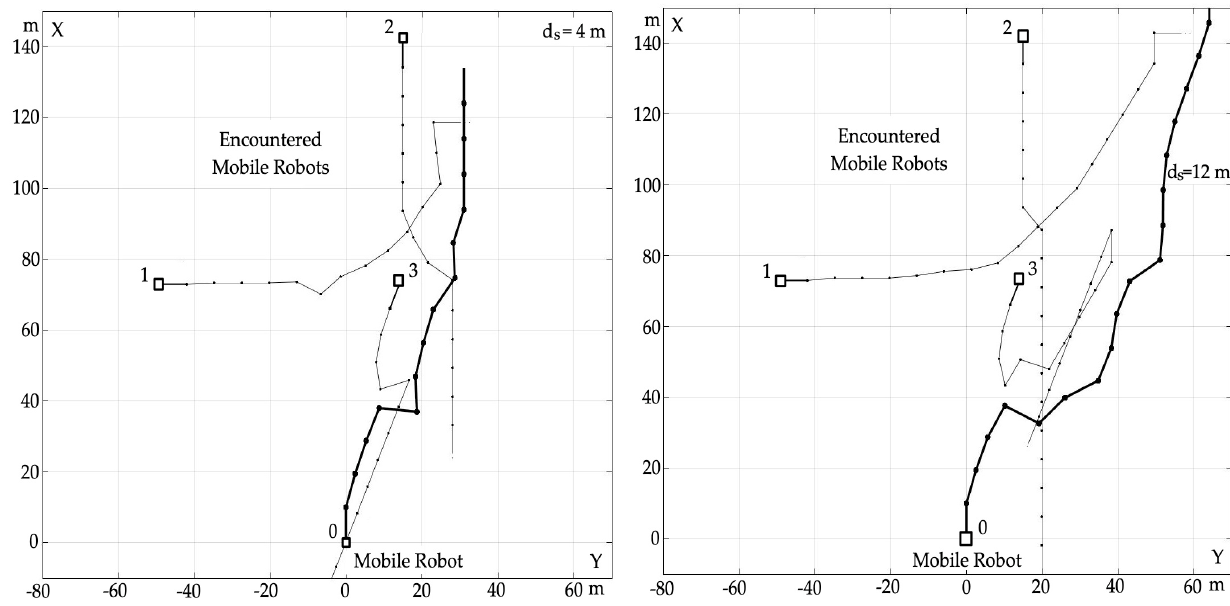
Figure 7. Mobile robot safe path when passing K = 3 encountered mobile robots in good weather conditions ( d s = 4 m) and in unfavorable weather conditions ( d s = 12 m), determined by the MG_nc algorithm of the non-cooperative matrix game.